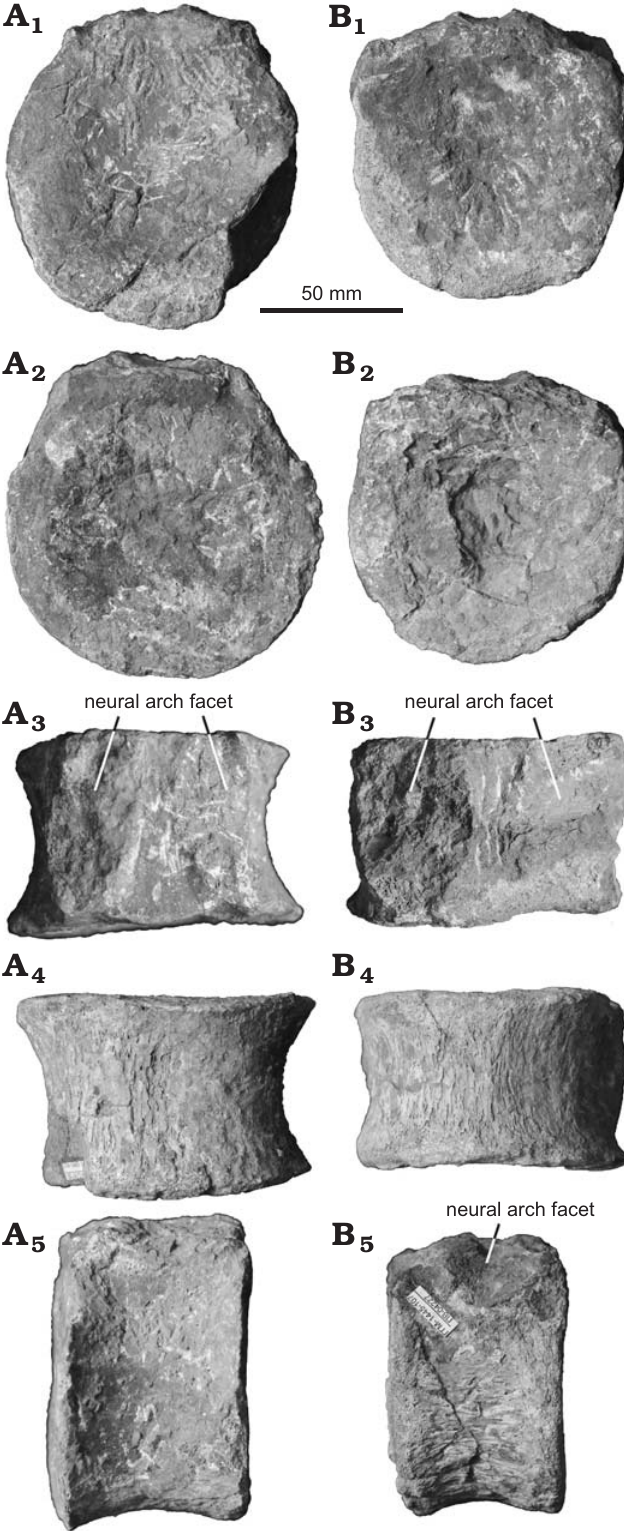
Fig. 4. Dorsal centra of the plesiosaur Rhomaleosauridae indet. from the Lower Callovian Hlebnovka Formation of “Konnyi barak” ravine, Russia. SGM 1445-108 ( A ) and SGM 1445-107 ( B ), in anterior (A (A , B ), dorsal (A , B ), ventral (A 2 2 3 3 (B ) 5